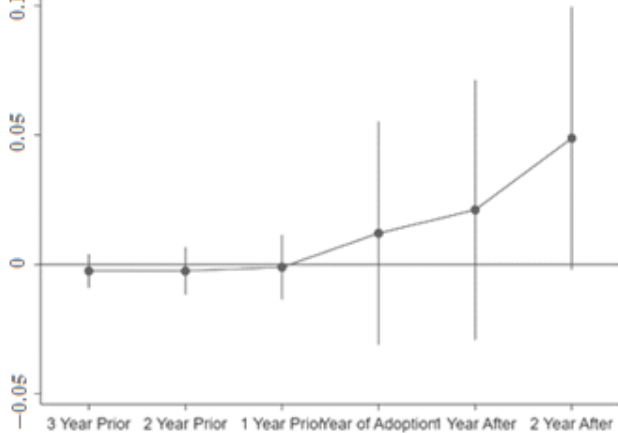
Figure 3. Parallel trend test results.